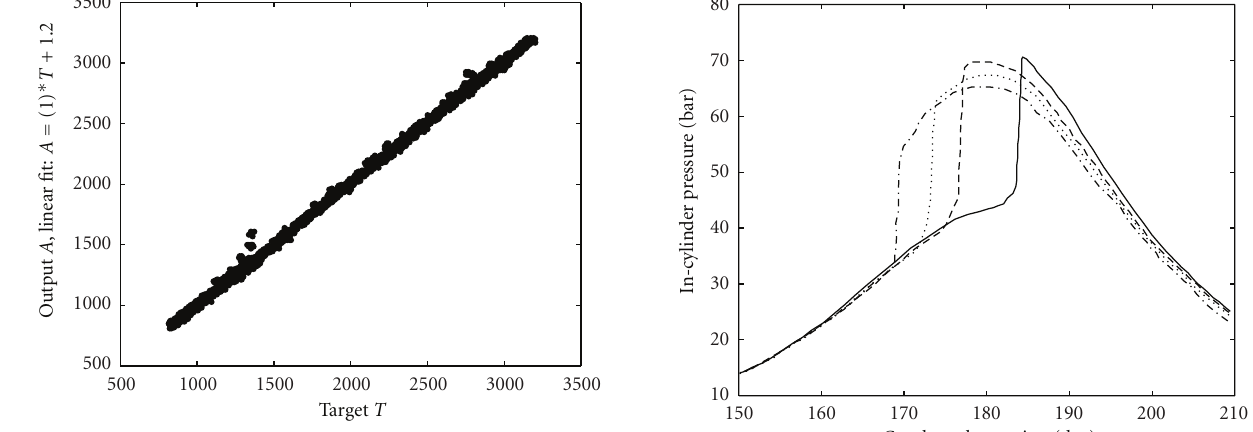
Figure 8: Comparison between TNN output and target in-cylinder temperature (training data).